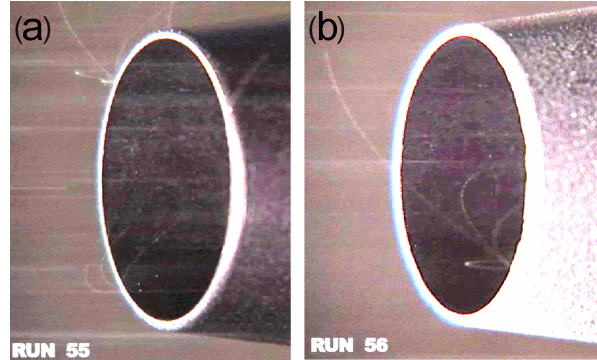
Figure A1. Snapshots from a high-speed video of trajectories of shattered and rebound ice particle fragments formed on impact with the CPI inlet. The measurements were conducted in the Cox and Company, Inc. wind tunnel facility (Long Island, NY, USA) in ice spray at TAS = 80ms − 1 .